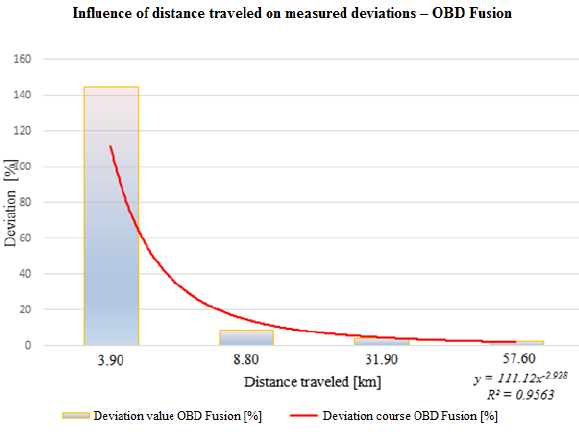
Figure 5: Influence of distance traveled on measured deviations – OBD Fusion